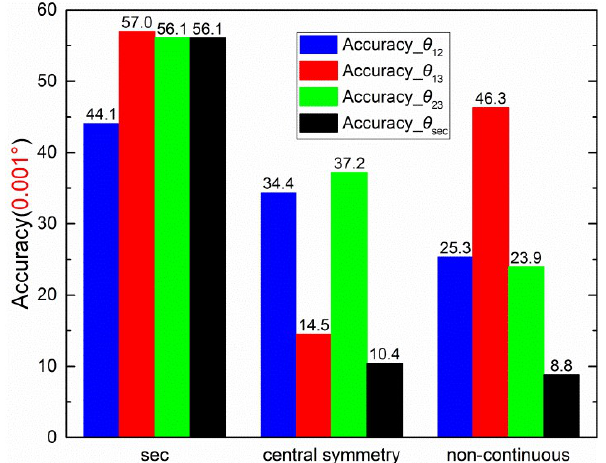
Figure 20. Summary of accuracies of three types of calibration.